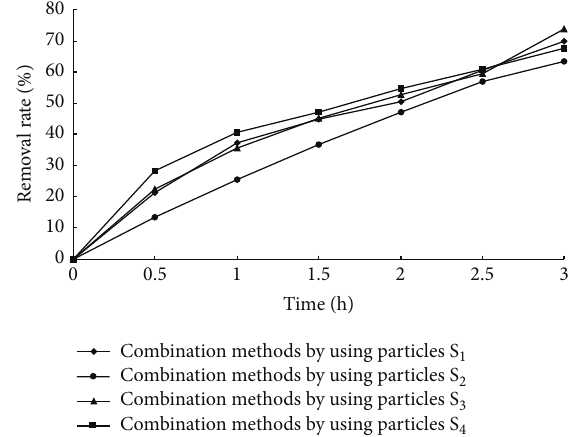
Figure 4: Degradation of MB solution with combination